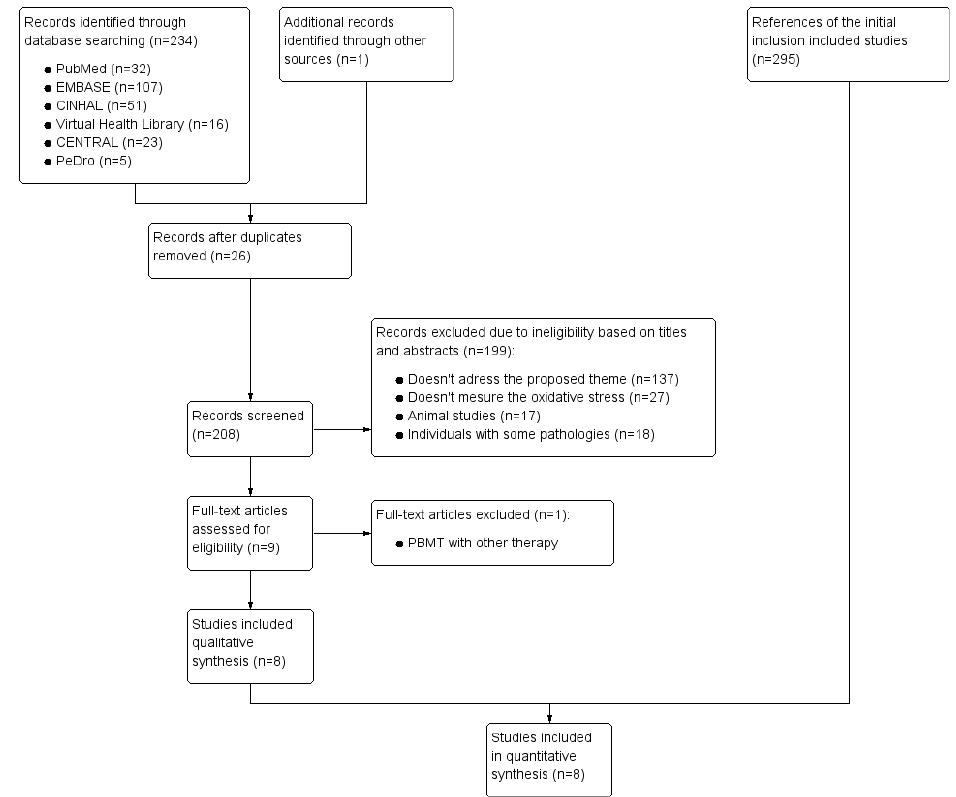
Figure 1. Flow of trials through the review. Table 1. Characteristics of included trials.